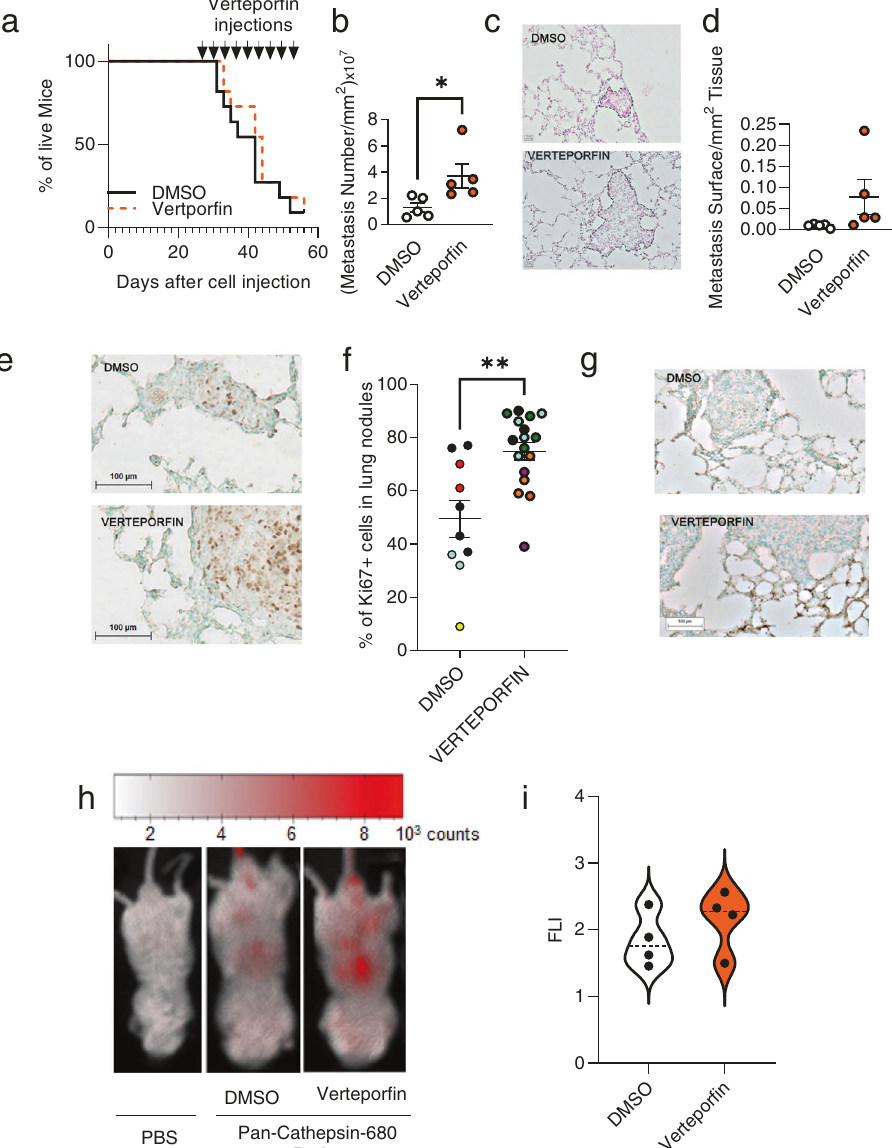
Fig. 8 The effects of vertepor fi n on developed tumors is associated with in fl ammation. a Mice with bone tumors were treated with DMSO or vertepor fi n as indicated (arrows). Survival curves indicating the proportion of living mice. n = 11 DMSO-treated mice, n = 11 Vertepor fi n- treated mice. b – d Quanti fi cation of lung metastases in these mice. b Results are mean ± SEM number of lung nodules per mm 2 of analyzed tissue. c Representative photos of lung tumor nodules in DMSO- (upper panel) and vertepor fi n- (lower panel) treated mice. d Results are mean ± SEM surface of lung nodules per mm 2 of analyzed tissue. e Representative photos of Ki67 immunostaining in lung metastases of DMSO- and vertepor fi n-treated mice. f Percentage of Ki67-positive cells in lung metastases of DMSO- vs vertepor fi n-treated mice. Results are mean ± SEM. ** p < 0.01. Colored dots discriminate the 3 different mice analyzed. g Representative photos of NF-KB (p65) labelling in cells around the metastases in lungs of DMSO- vs vertepor fi n-treated mice. h Detection of cathepsin activity in mice with fast-growing bone tumors treated with DMSO or vertepor fi n as indicated. At 24 h after NIR imaging, the mice were injected with PBS (sham injected) or a pan- cathepsin probe. i Quantif i cation of the NIR signal in lungs of DMSO- vs vertepor fi n-treated could reverse CSC chemoresistance in sarcomas and the possible impact on disease recurrence. Although vertepor fi n has anti-tumor effects by inducing of the death of actively dividing CSCs during early stages of tumor development, YAP inhibition resulted in increased metastasis development in mice with fast-growing tumors. This fi nding agrees with the consensus that YAP controls the size of progenitor cell populations but has opposing effects to regulate stem cell fate [12, 13, 51]. In contrast, our data show that the pro-tumoral effect of vertepor fi n can be via actions on the host tissues. YAP controls